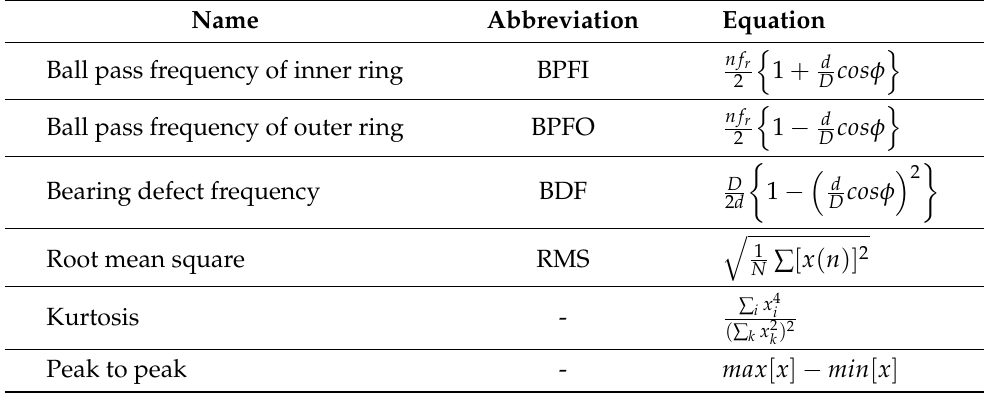
Table 3. Selected features, abbreviations, and